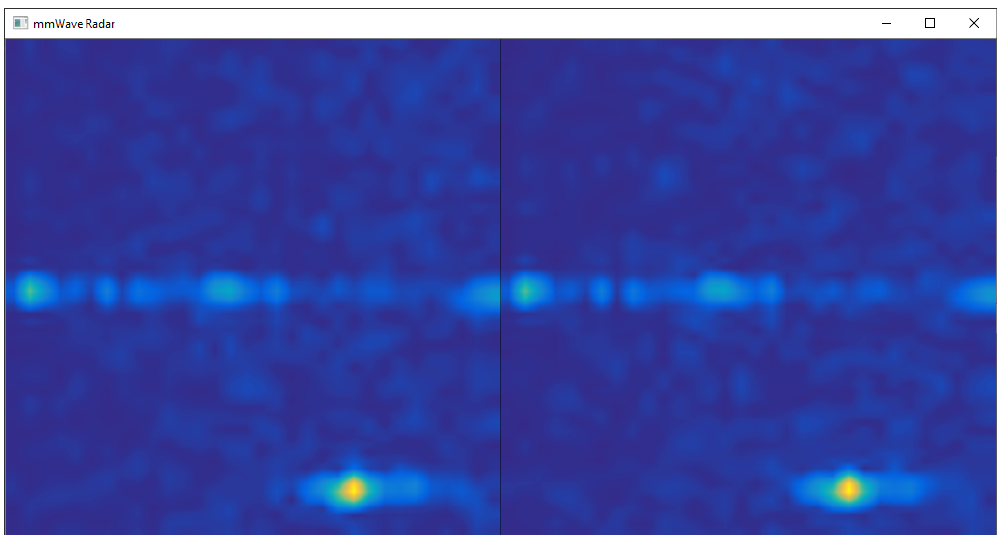
Figure 17. Radar DSP output for SNR = 6.44, − 0.46, and − 5.76. On the left, no attack, and on the